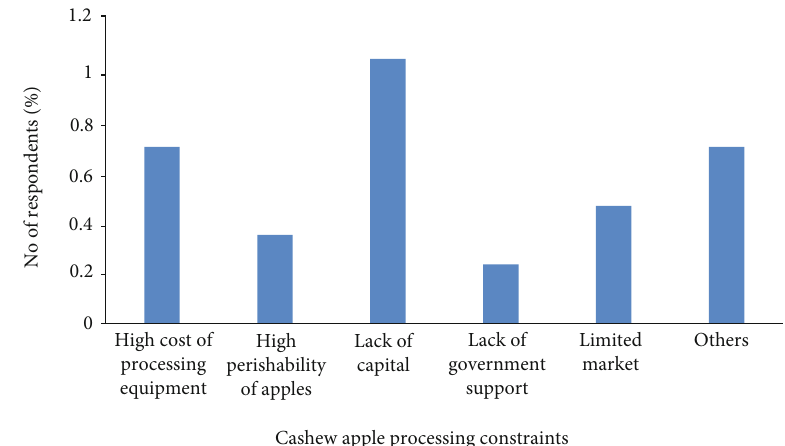
Figure 8: Challenges of cashew apple processors in Ghana. Note: others refer to responses outside the thematic